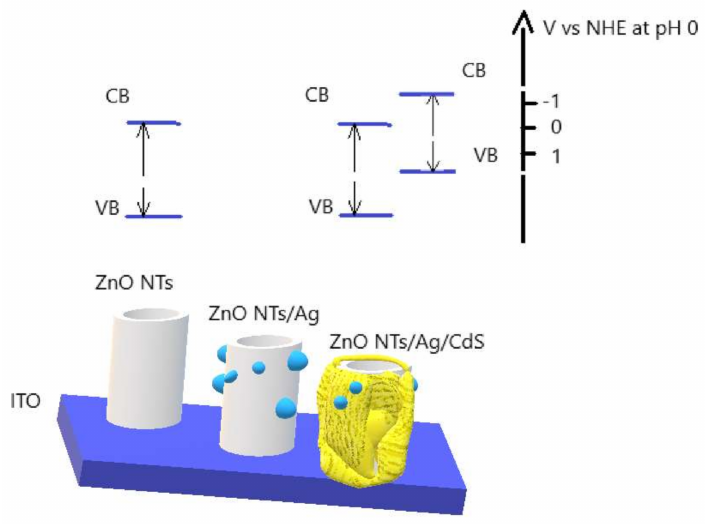
Figure 7. Schematic representation of obtained photoactive materials with respect to NHE at pH 0.